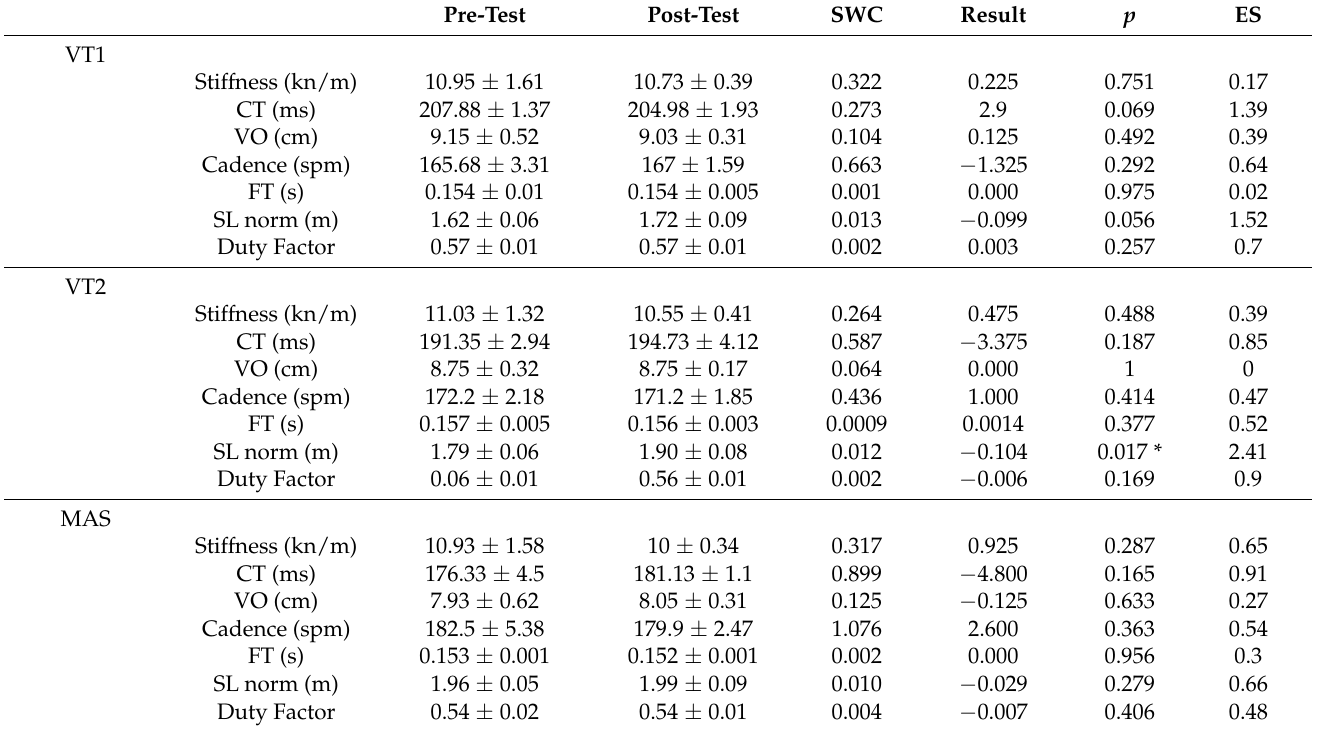
Table 3. The pre-test and post-test biomechanical parameters for running after 29 weeks